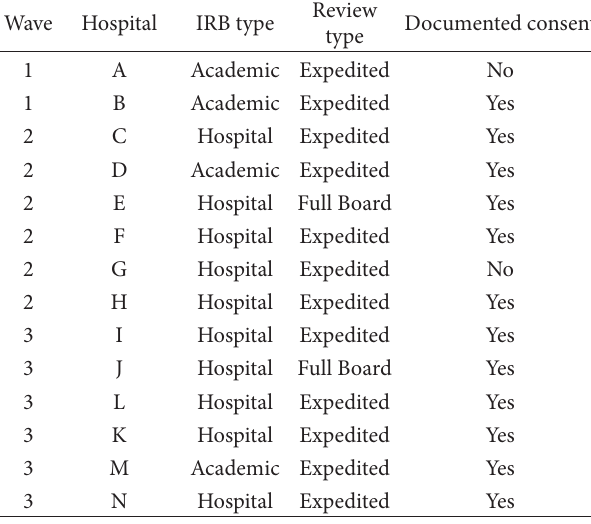
Table 1: IRB Review type and requirement for documented consent. Wave